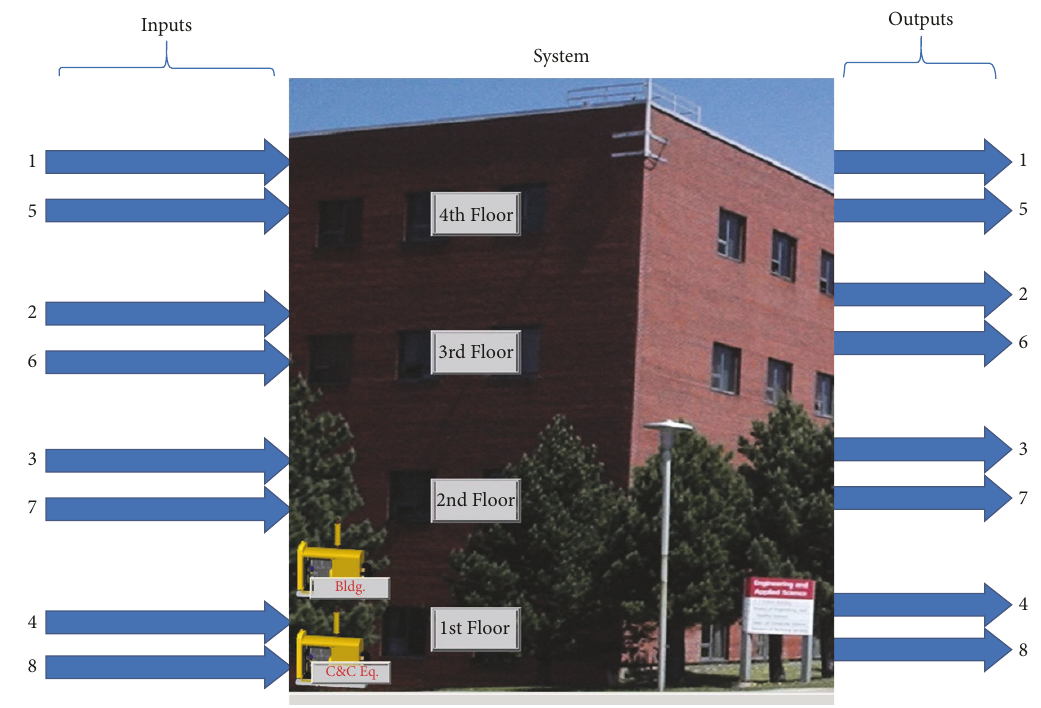
Figure 8: System with eight inputs and eight